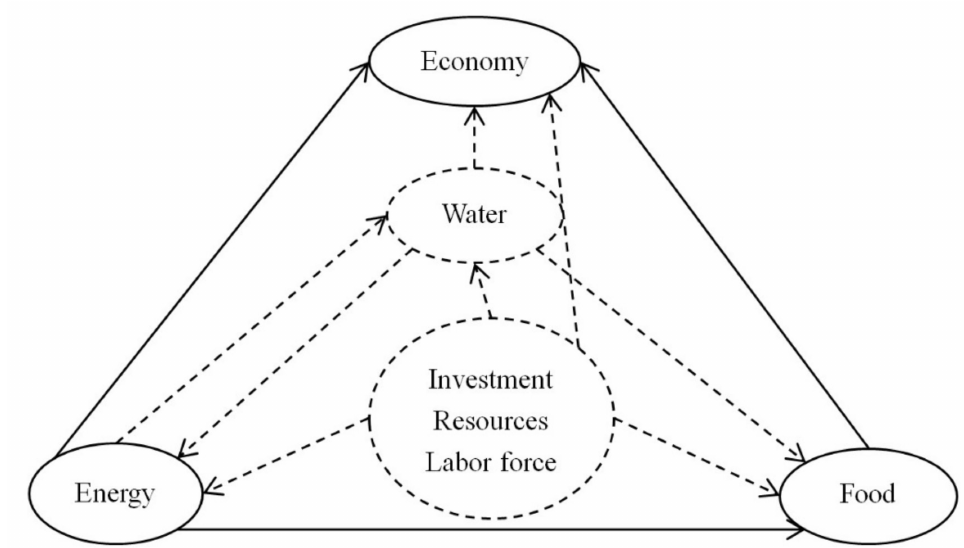
Figure 1. Three-dimensional network structure of the WEF-Eco system.